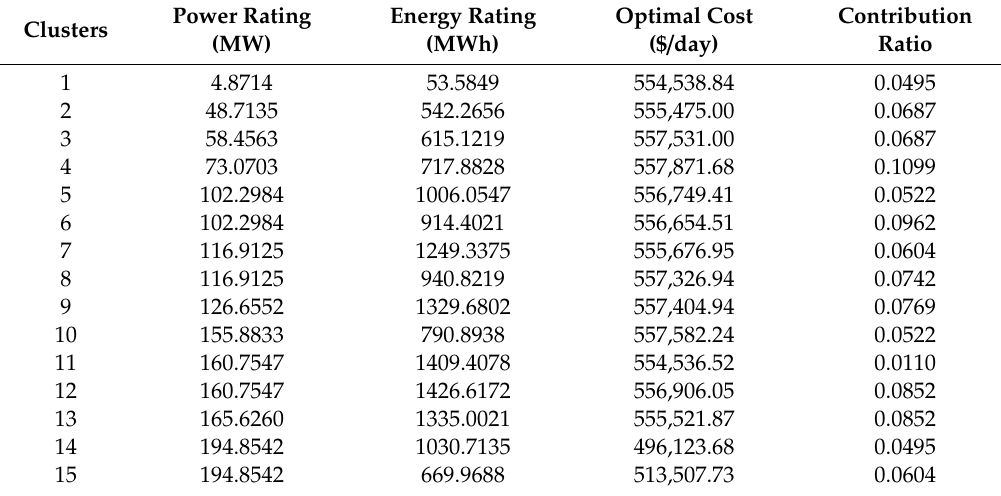
Table 2. Computation results of representative data for case 2.